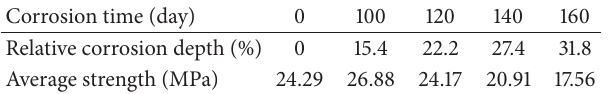
Table 7: Relative corrosion depth and the corresponding average strength of corroded concrete reported in the literature [27].